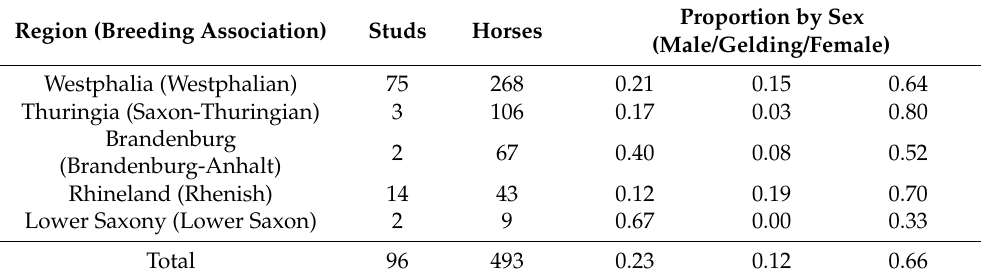
Table 1. Number of sampled Rhenish German draught horses by region, horse breeding association and sex (n =